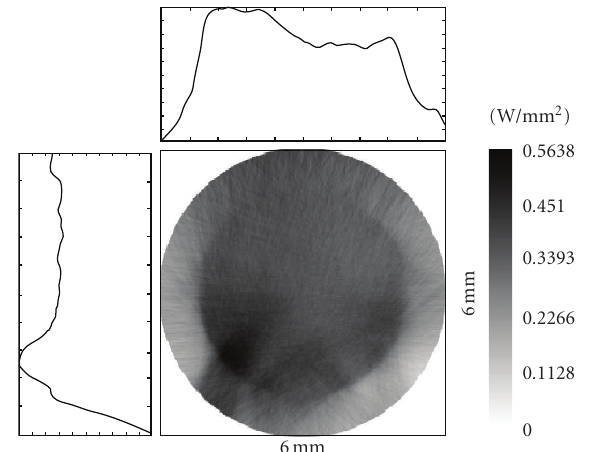
Figure 3: Gray-scale absorption distribution for the 6mm diameter Nd:YAG rod within the 3D-CPC-2D-CPC cavity (angular tracking error 2mrad, vertical unit in W/mm 2 ).